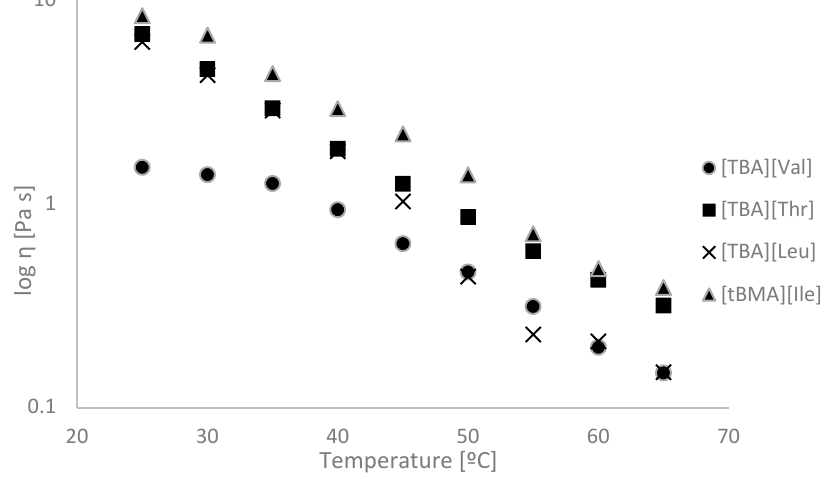
Figure 2. Variation in the viscosities of the tetrabutylammonium amino acid ionic liquids (AAILs) with temperature.